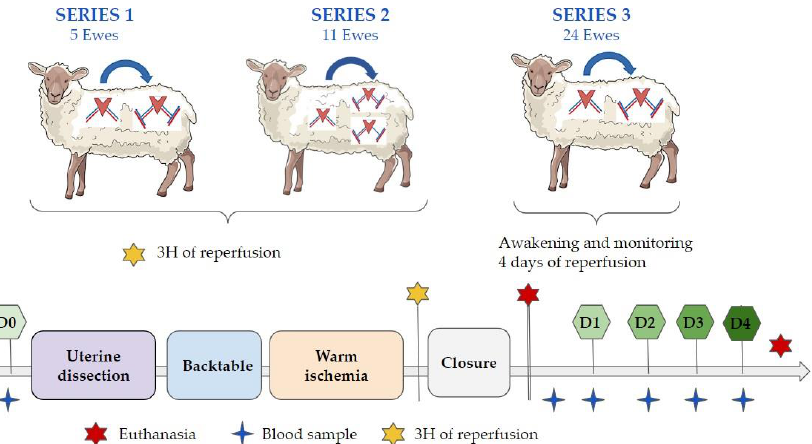
Figure 2. Experimental protocol and the main operating times. D0: day zero, D1: day one, D2: day two, D3: day three, D4: day four.